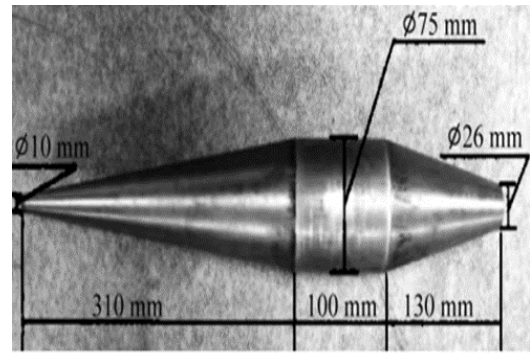
Figure 11. Spinning cone bullet.